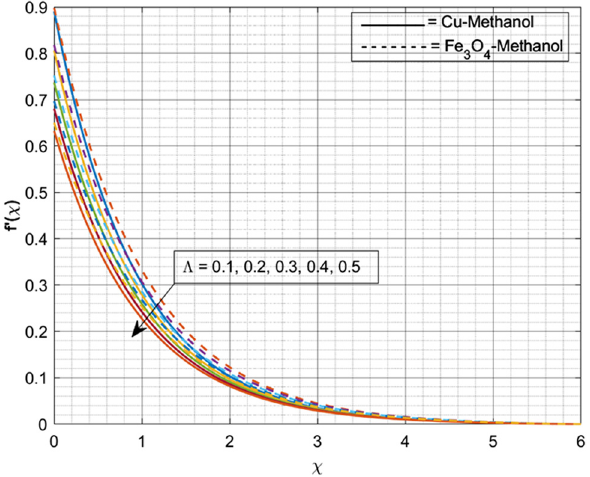
Figure 4: Sway of Λ on f ′ .